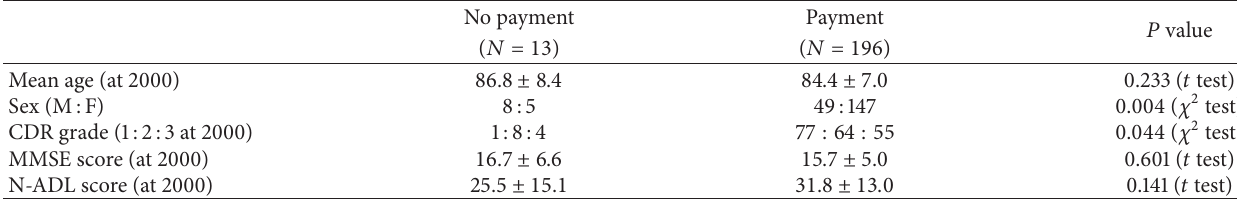
Table 1: Comparison between subjects who received payment and those who did not.